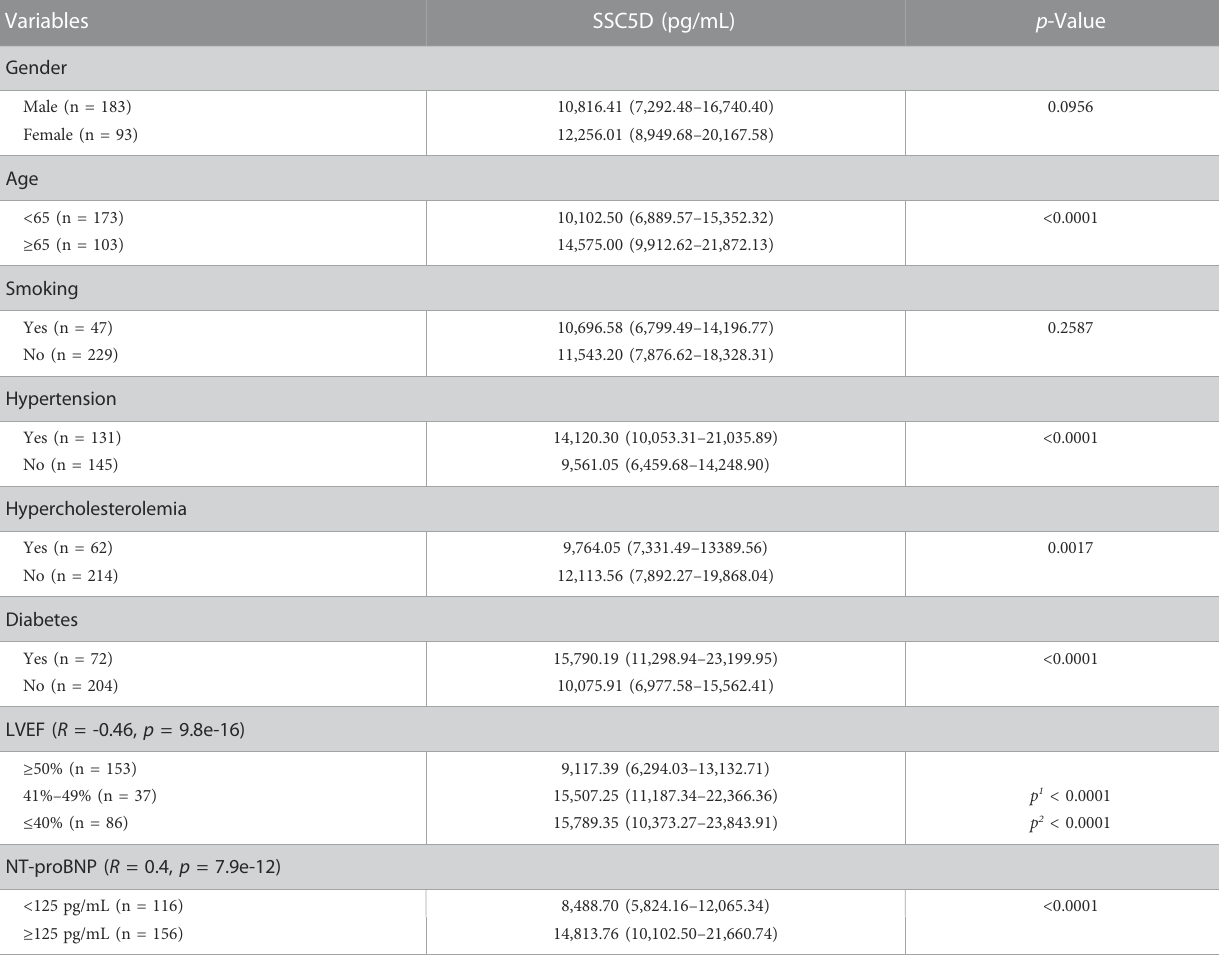
TABLE 2 Correlation analysis between HF risk factors and SSC5D concentrations.